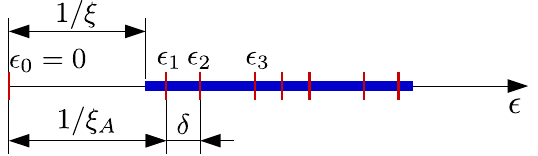
FIG. 1. Illustration of the idea behind the scheme. This represents (the logarithm of) the dominant part of the transfer matrix spectrum in a generic situation. The blue line represents continuous band necessary to recover the algebraic part of the correlation function asymptotics in Eq. (2). In this case the exact correlation length is set by the gap between the bottom of the band and the origin, ϵ 0 ¼ 0 . The spectrum of the transfer matrix for finite bond dimension MPS, represented here by red marks, is necessarily discrete and as such can only approximate the continuous band. Consequently, 1 = ϵ 1 is typically underestimating the true value of the correlation length. We employ δ ¼ ϵ 2 − ϵ 1 as a natural measure of how well the discrete spectrum is able to approximate the exact continuous one. By computing ϵ 1 ð D Þ and δ ð D Þ for some number of MPSs with different bond dimensions D , we extract the correlation length by extrapolating δ → 0